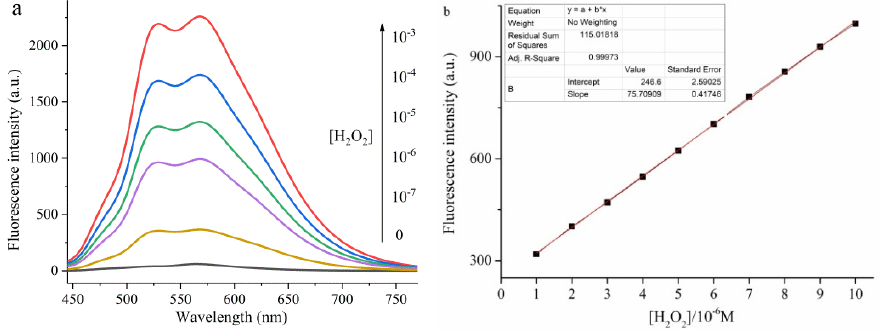
Figure 3. ( a ) Fluorescence spectra of FLA-Boe under different concentrations of H 2 O 2 (DMSO/H 2 O = 1/1, v / v , λ ex = 417 nm), ( b ) calculation of detection limits of FLA-Boe for H 2 O 2 (DMSO/H 2 O = 1/1, v / v ).